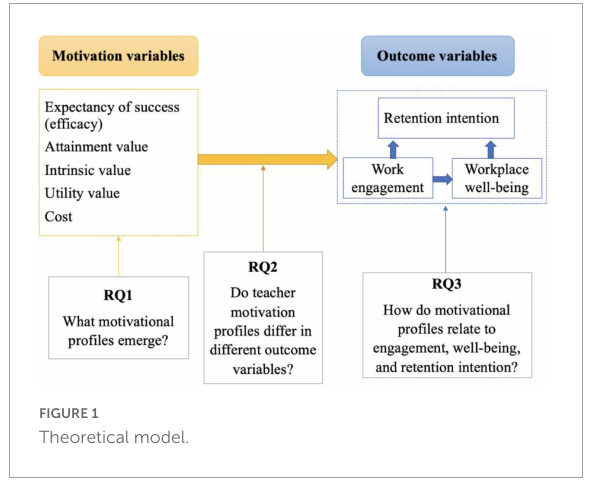
FIGURE1 Theoretical